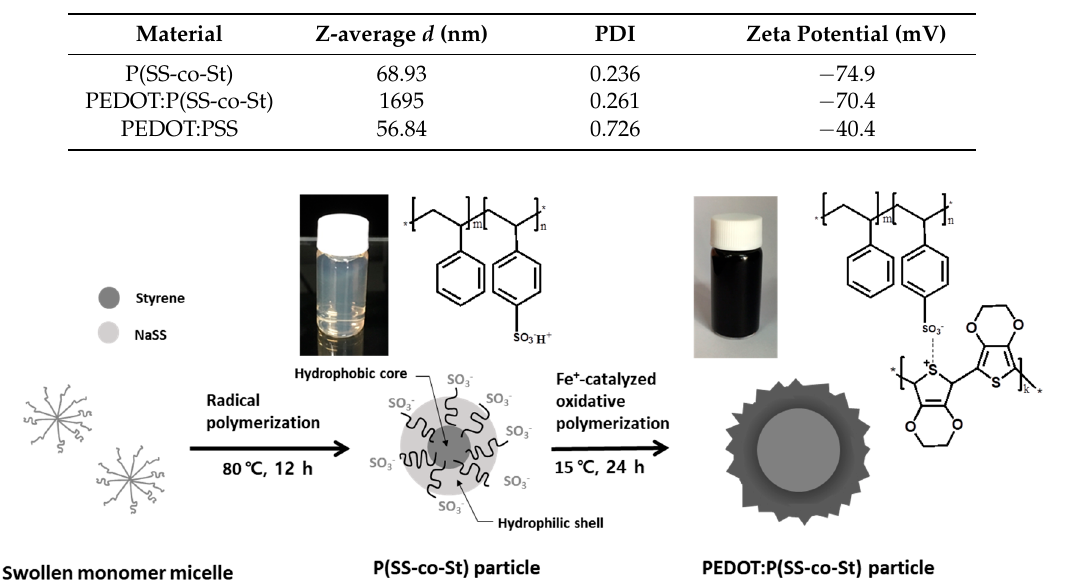
Figure 4. Solution-stability comparison of ( a ) pristine PEDOT:PSS and ( b ) PEDOT:P(SS-co-St).